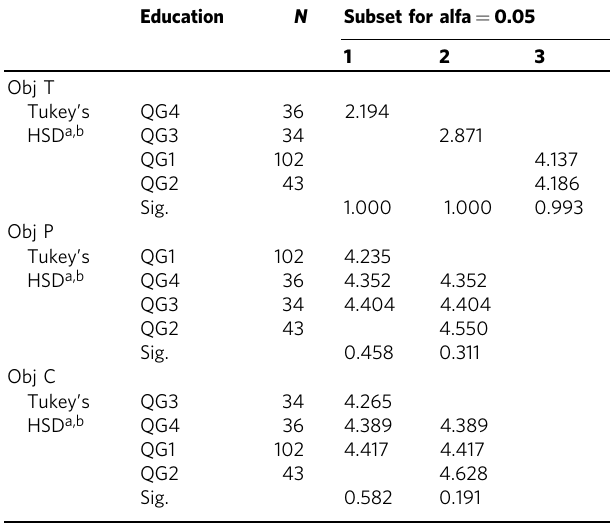
Table 10 Classi fi cation of groups according to the similarity of their averages regarding the “ objectives ” variable.